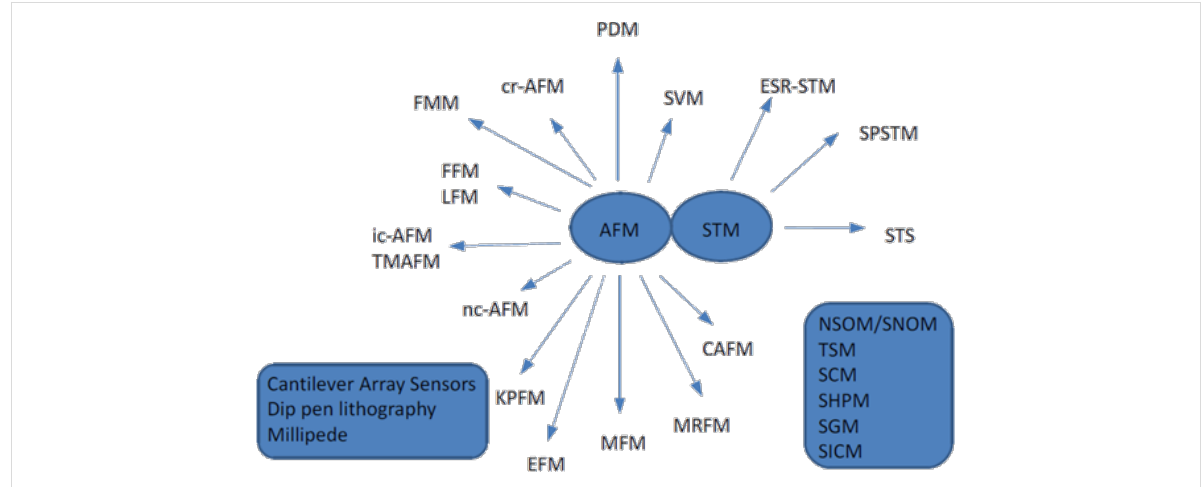
Figure 1: Scanning probe microscopy: A large familiy of microscopes, which have in common that they use local probes to characterize surfaces. AFM: Atomic Force MicroscopySTM: Scanning Tunneling Microscopy, PDM: Phase Detection Microscopy, FMM: Force Modulation Microscopy, ic-AFM: intermittent contact AFM, TMAFM: tapping mode AFM, nc-AFM: non-contact AFM, KPFM: Kelvin probe force microscopy, EFM: Electrostatic force microscopy, MFM: Magnetic force microscopy, MRFM: Magnetic resonance force microscopy, NSOM: Near-field scanning optical microscopy, SNOM: Scanning nearfield optical microscopy, TSM: Thermal scanning microscopy, cr-AFM: contact-resonance AFM, SPSTM: Spin polarized STM, SHPM: Scanning Hall probe microscopy, SGM: Scanning gate microscopy, SVM: Scanning voltage microscopy / Nanopotentiometry, ESR-STM: Electron spin resonance-STM, SICM: Scanning ion conductance microscopy, CAFM: Conductive